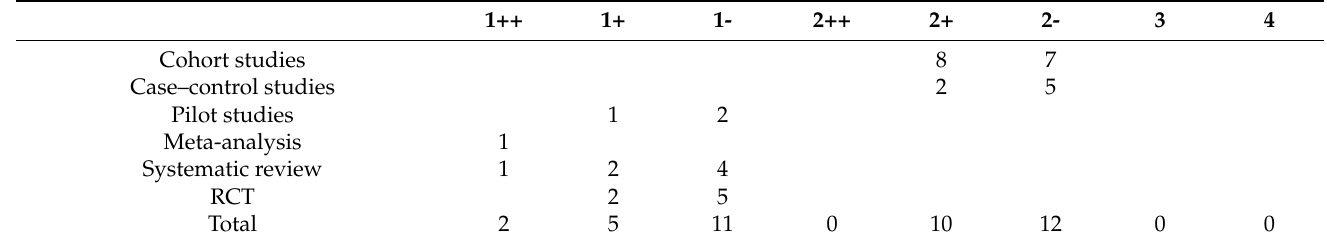
Table 2. Levels of evidence and grades of recommendation according to SIGN.